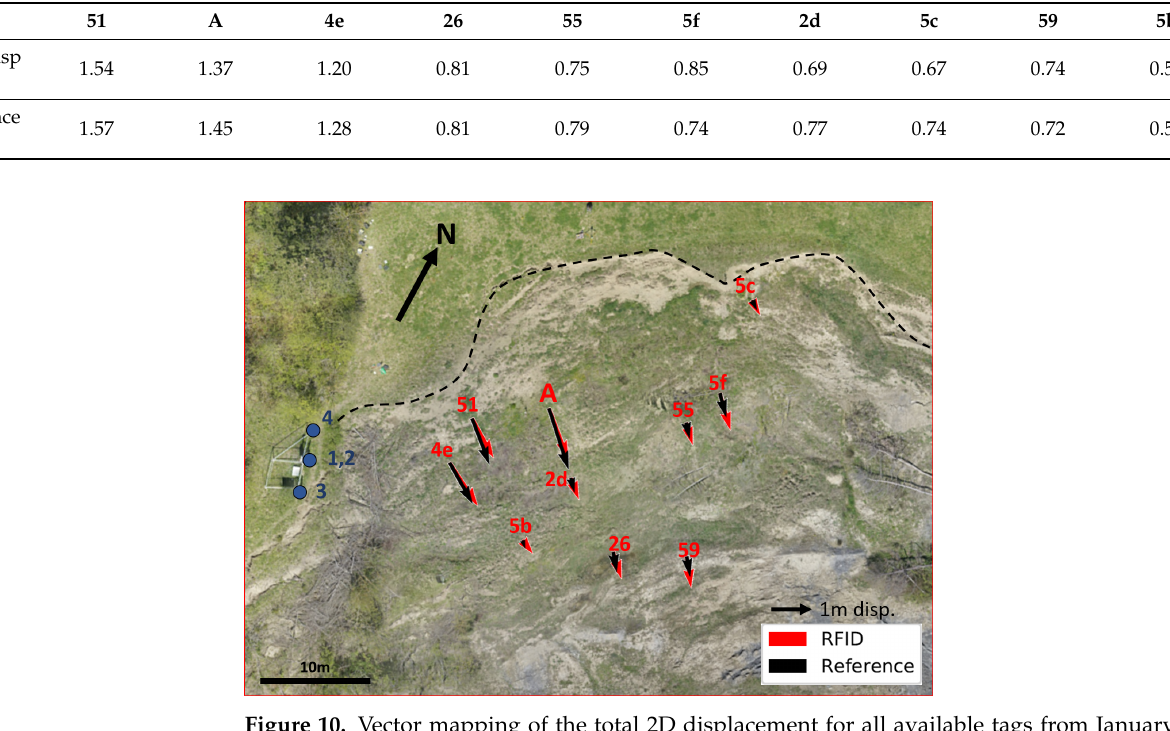
Figure 10. Vector mapping of the total 2D displacement for all available tags from January 2021 to September 2021. The scale is modified for clarity with a 1 m displacement reference (black arrow). The red arrows represent the displacement estimated from the RFID measurements, and the black arrows represent the displacement computed from reference measurements. The blue points numbered 1 to 4 correspond to the reader